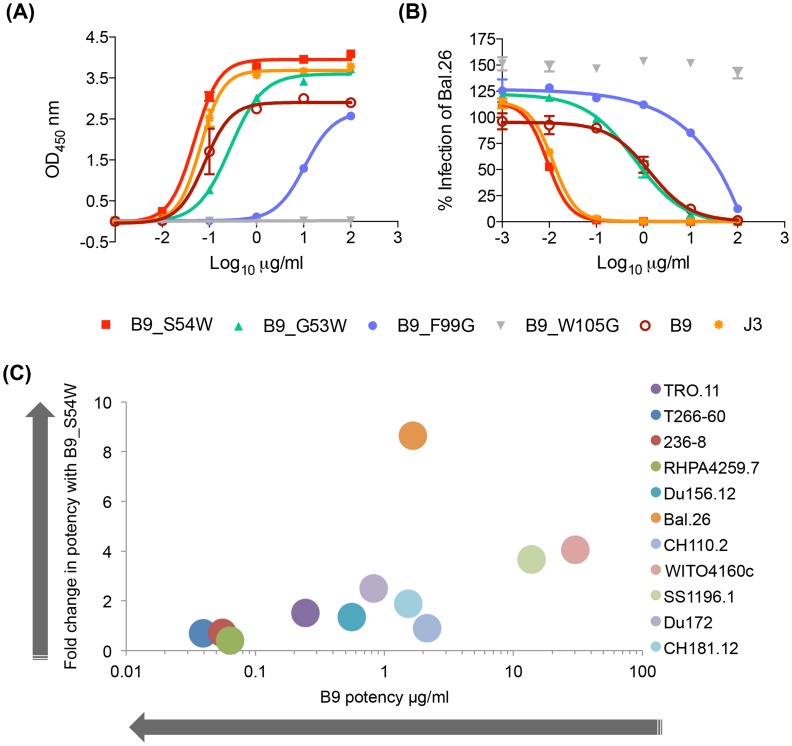
VHH mutation alters affinity, potency and breadth of neutralization.(A) VHH binding to clade B gp120 Bal.26 in ELISA detected by their C-terminal Myc tag. (B) VHH neutralization of Bal.26 HIV pseudovirus in the TZM-bl assay. Mutant VHH were generated by site-directed mutagenesis as detailed in the Materials and Methods. (C) The fold change in IC50 µg/ml values for B9 S54W relative to B9, indicating the increase potency of the mutant are plotted on the Y-axis. The IC50 µg/ml values for B9 against each virus in the legend are plotted on the X-axis, indicating the baseline potency of B9. All assays were carried out in duplicate and error bars represent standard deviation. These data are representative of at least three independent experiments.